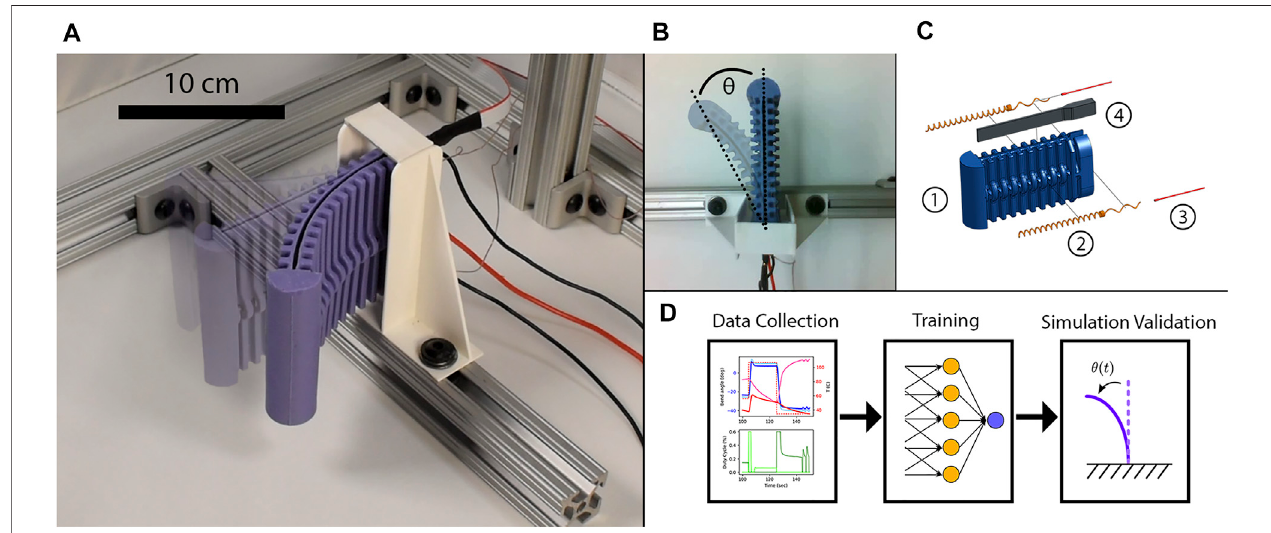
FIGURE 1 |(A) This article developsa framework for sensing and dynamics modeling ofa soft, planar, electrothermally-actuated shape memory alloy (SMA) robot limb. (B) Theprototype soft limb has asingle degree-of-freedom, θ , for planar motion. (C) The limb is cast from bulk silicone (C1), and is actuated bytwoshape memory alloy(SMA)coils(C2)containedinaridgealongbothsidesofthelimb.OursensorsincludethermocouplesattachedtoeachSMA(C3)andasoftbendingsensor(C4)for de fl ection and temperature measurements. Full assembly is detailed below. (D) Our framework consists of data collection of the limb undergoing various motions, used to train our LSTM neural network, with the outputs validated in simulated rollouts of de fl ection angle.